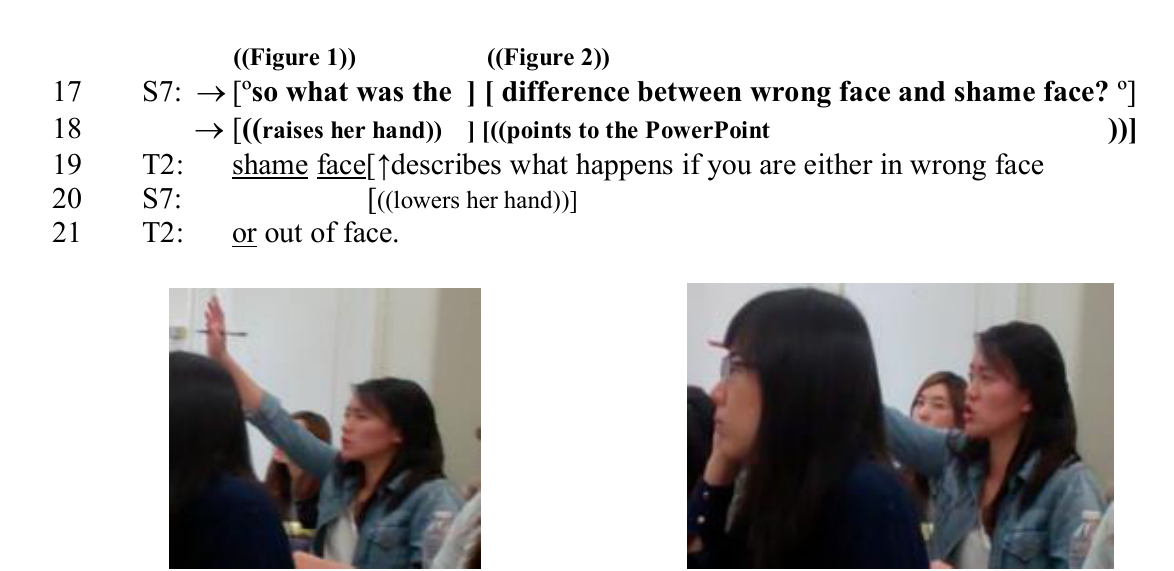
Figure 1 : Onset of line 17: “so what was - ” Figure 2 : Middle of line 17: “ difference between-